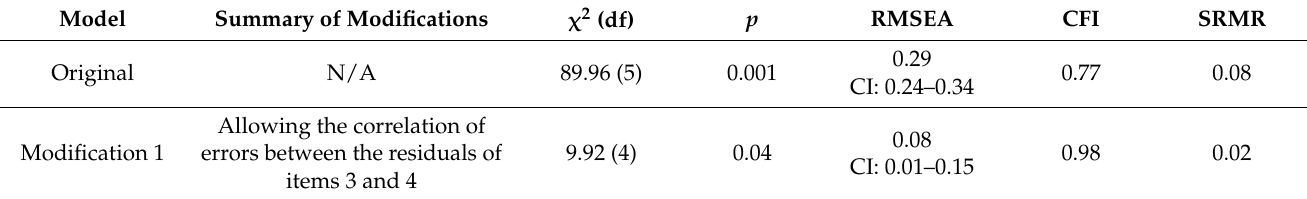
Table 2. Summary of original model, and the model